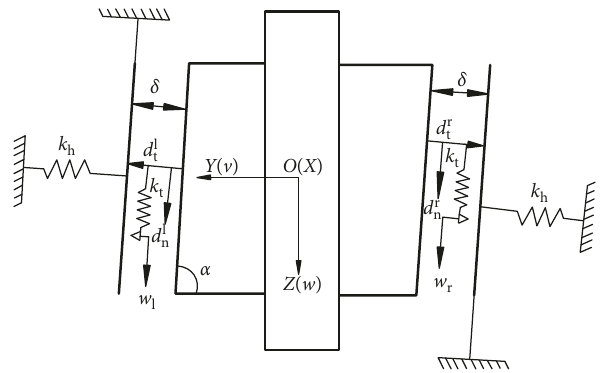
Figure 2: A specific model diagram of shrouded model, d l and d r are the tangential displacement of the left t t and right-side shroud, respectively, and d 1 normal displacement of the left and right-side shroud.